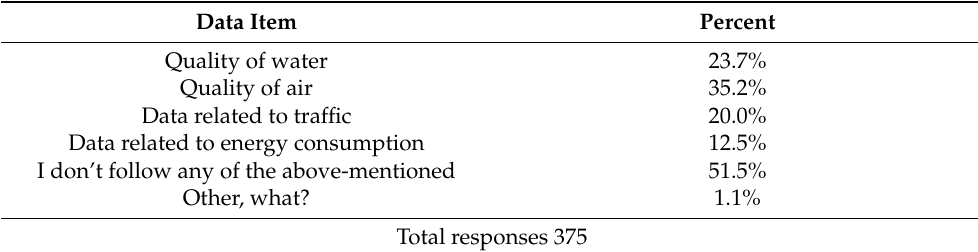
Table A8. The open data of Oulu followed by the respondents.